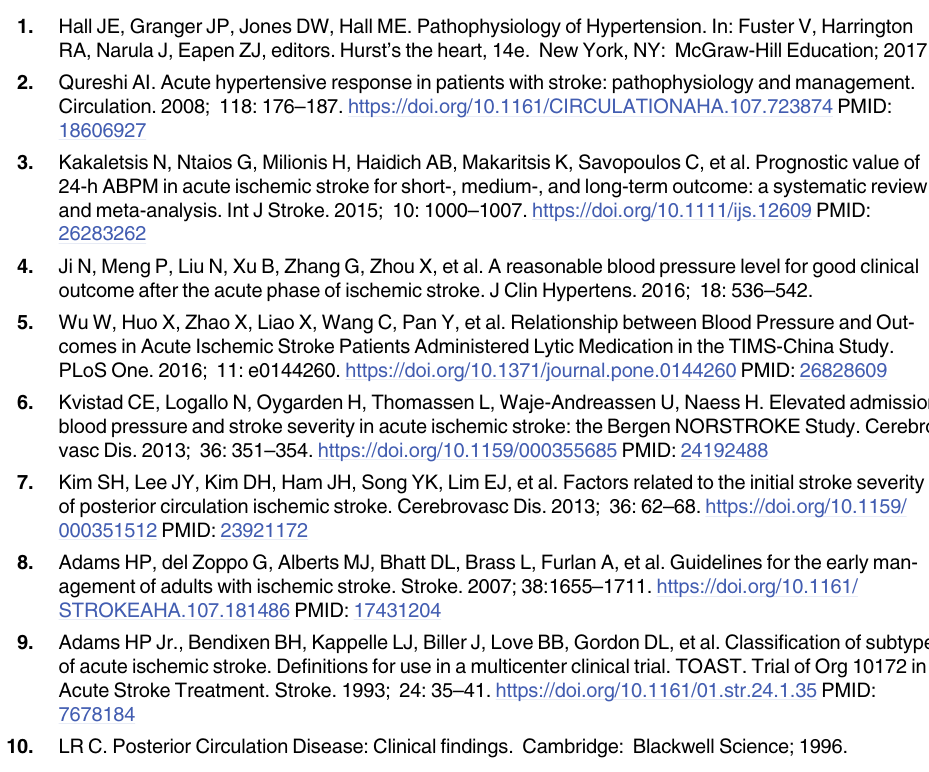
S1 Table. Patient characteristics in LAO subgroup. S2 Table. Patient characteristics in TPA